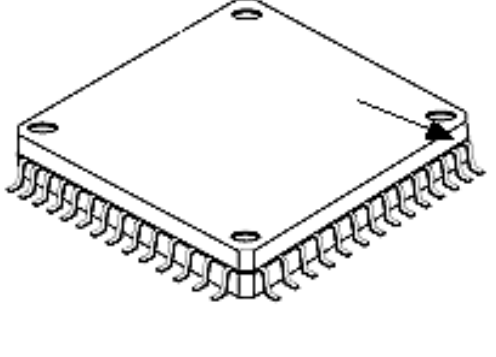
Fig. 4. Usual lead failure location for QFP components, close to package